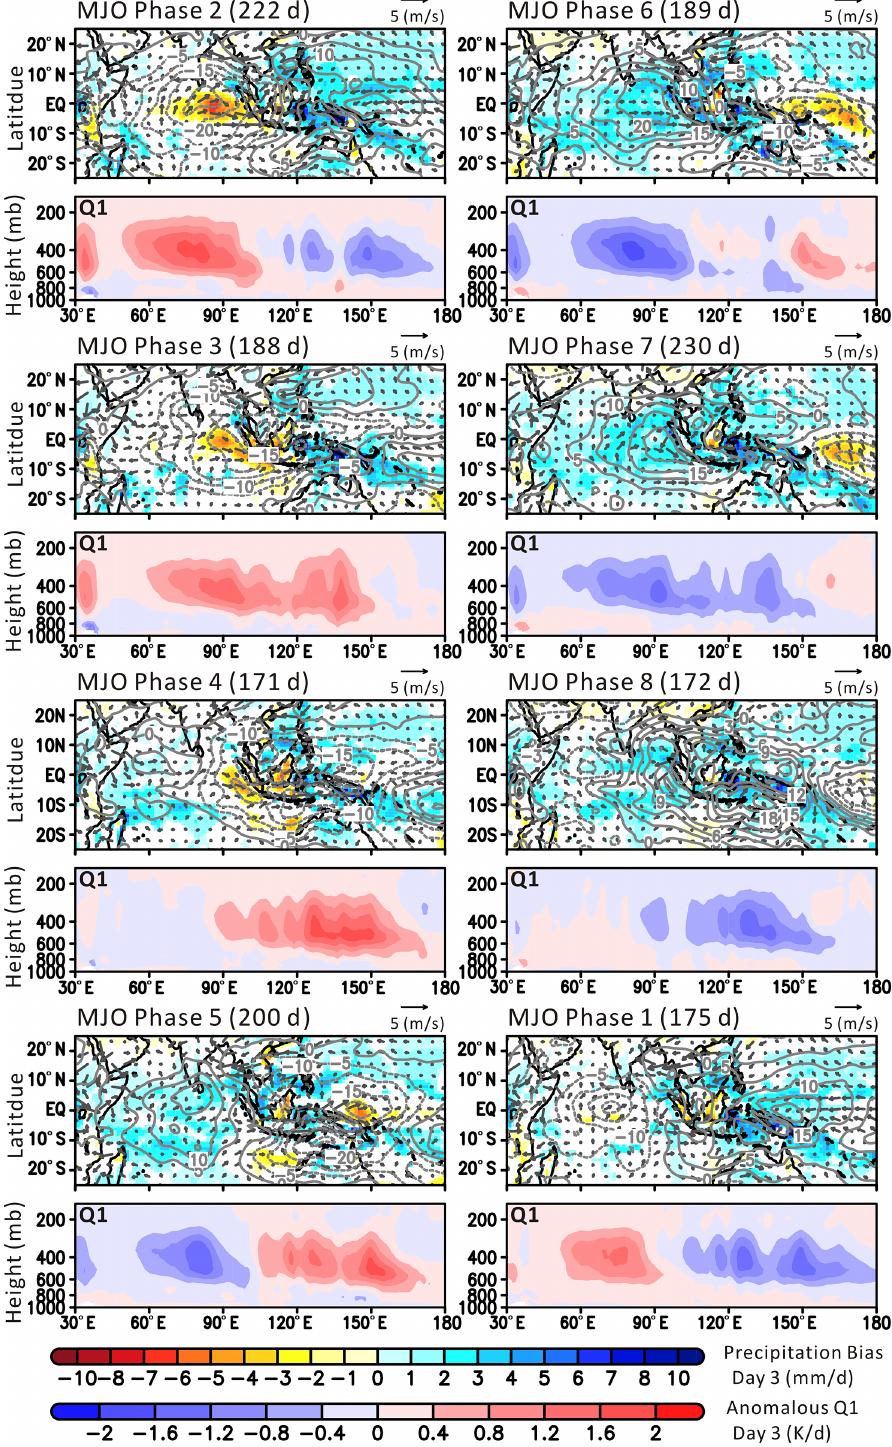
Figure 5. Composites of November to April precipitation bias (color shades, mmd − 1 ), 850hPa horizontal wind biases (vectors, ms − 1 ), and anomalous 20–100d bandpass-filtered Q1 vertical profiles (averaged over 10 ◦ S to 10 ◦ N, Kd − 1 ) from day 3 hindcasts, as a function of the eight phases of the MJO (Wheeler and Hendon 2004). The number of days comprising each composite is indicated at the top of each panel. The observed precipitation and winds are from GPCP and ERA-Interim, respectively. Only precipitation biases that are significant at the 95% confidence level are shaded. The Q1 profiles are computed directly from the model’s tendency terms with all the diabatic